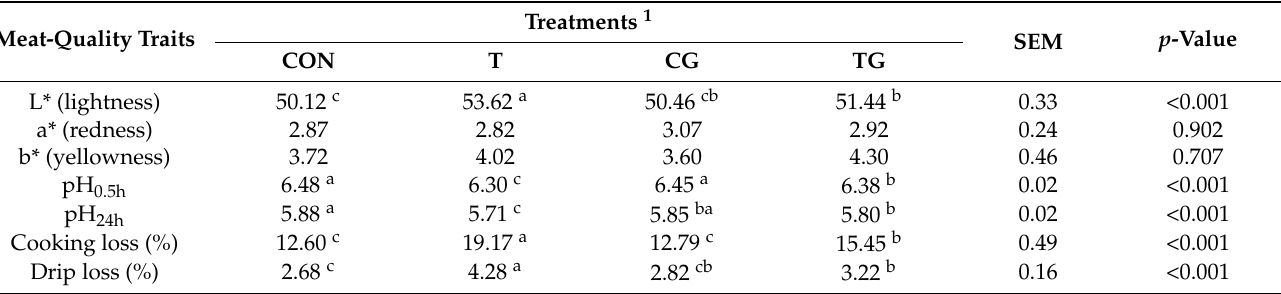
Table 1. Effects of heat shock protein 70 expression on meat-quality traits of pectoralis major muscles of broiler chickens subjected to pre-slaughter